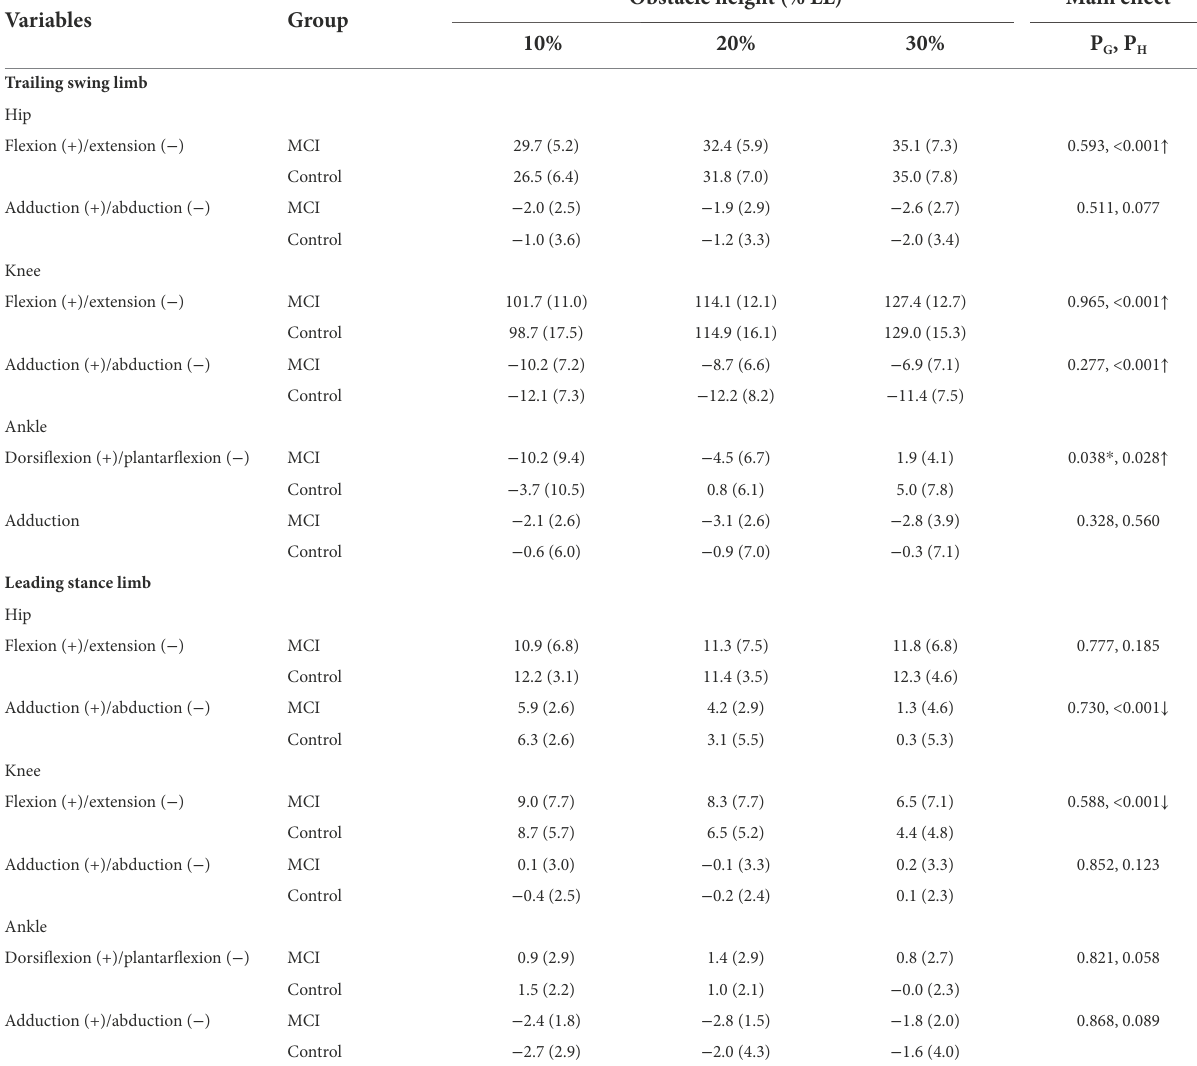
TABLE 5 Means (standard deviations) of the crossing angles of the hip, knee, and ankle joints of the trailing swing limb and leading stance limb in the patients with mild cognitive impairment (MCI) and healthy controls (Control) when the trailing toe was above the obstacle of heights of 10, 20, and 30% of subjects’ leg length